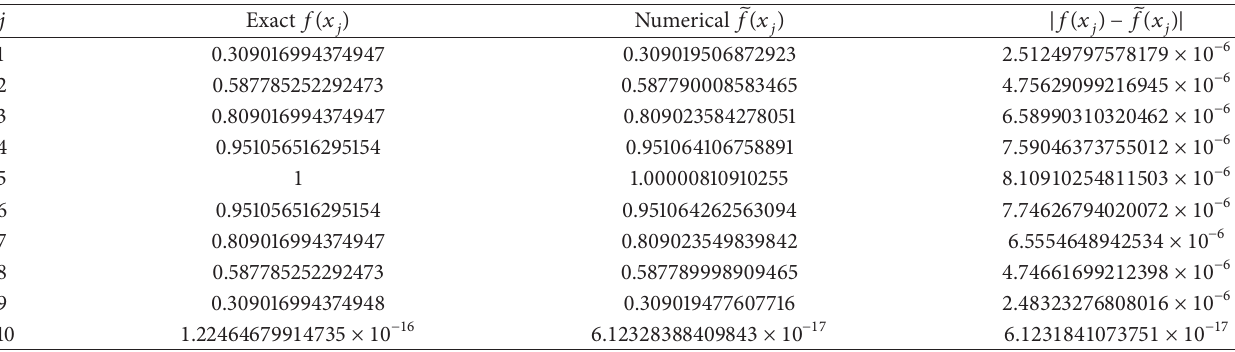
Table 5: 𝑇 = 1 , the analytical and numerical results for the 𝑓(𝑥 𝑗 ) in 𝑥 𝑗 = 0.1𝑗 , where 𝛿 = 0 .